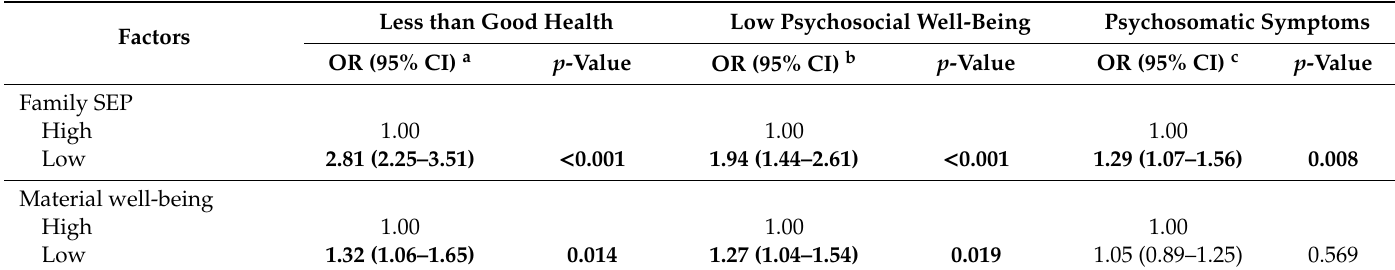
Table 4. Odds ratios (95% confidence interval) of poor health outcomes by family socioeconomic position and material well-being, adjusted for age and sex, and simultaneously controlling for both SES